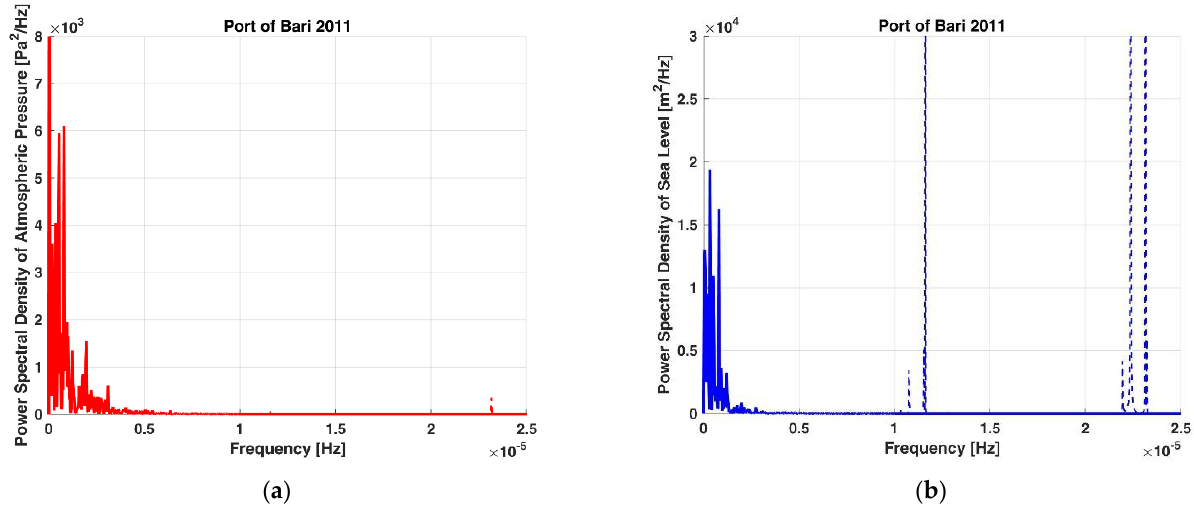
Figure 11. Power spectral densities of meteomareographic parameters acquired by ISPRA’s monitoring station in the port of Bari in 2011: ( a ) Atmospheric pressure; ( b ) sea level; solid lines: lowfrequency components surviving the filtering; dashed lines: highfrequency components eliminated by the filtering.